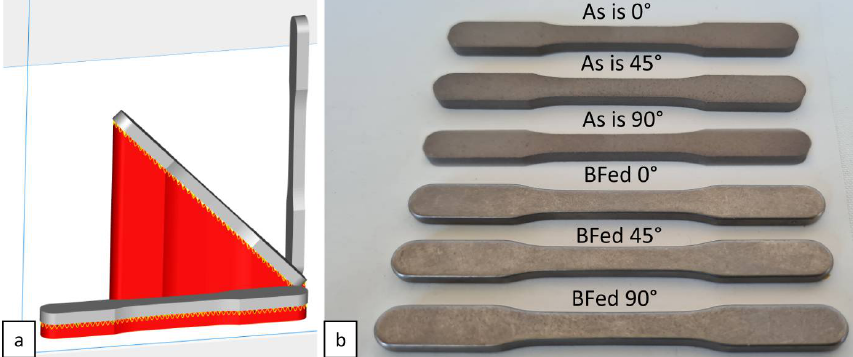
Figure 3. Specimen models and support structures; ( a ) fabricated specimens; ( b ) for different build- ing orientations before and after the BF employment.